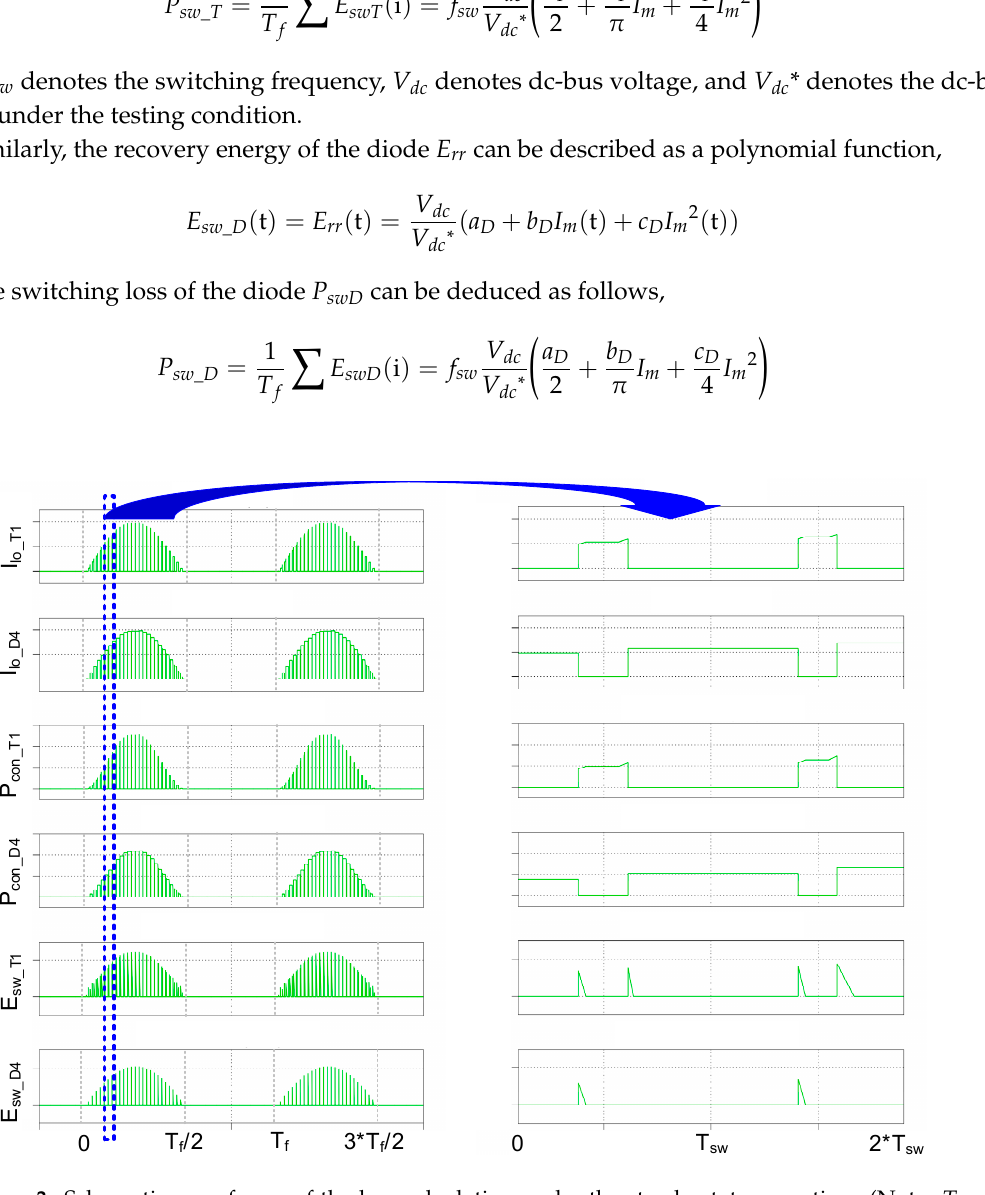
Figure 3. Schematic waveforms of the loss calculation under the steady-state operation. (Note: T f denotes the fundamental period, and T sw denotes the switching period.)